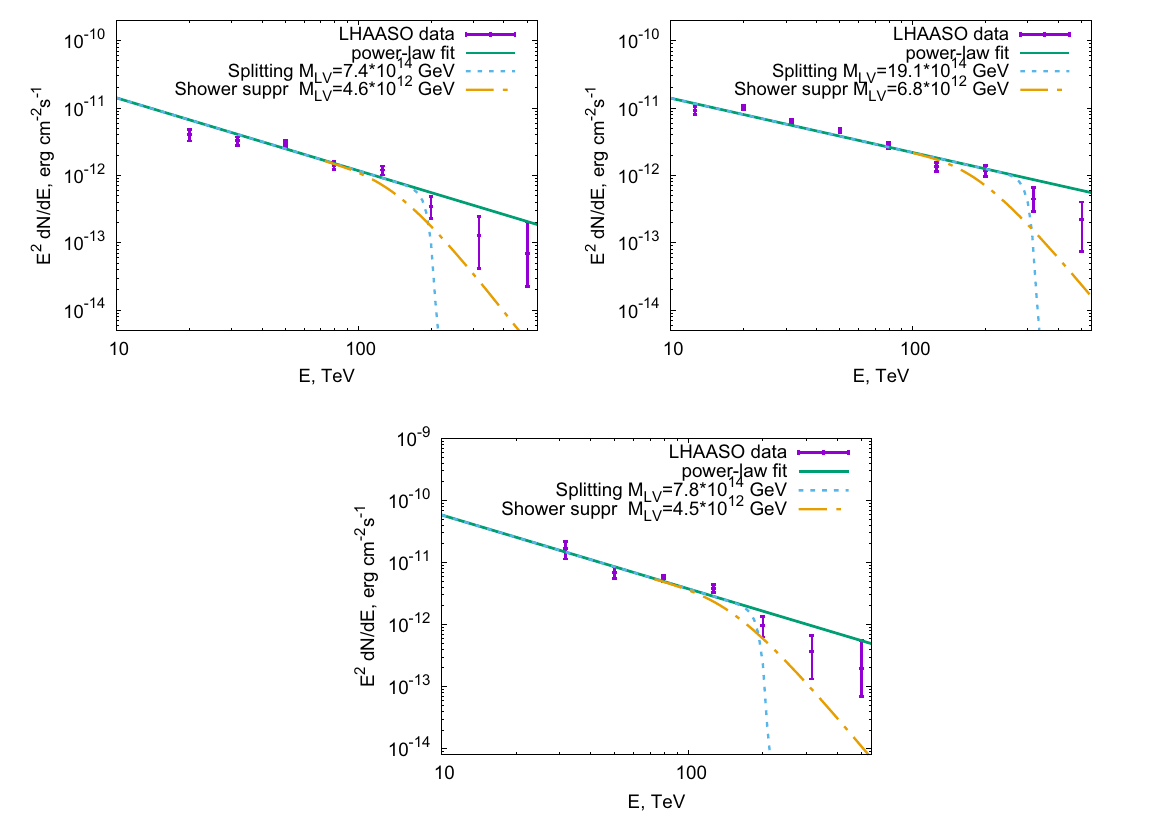
(yellowdash-dottedcurve)scenarios.Top-leftpanel:J2226+6057,Top- right panel: J1908+0621, Bottom panel: J1825-1326